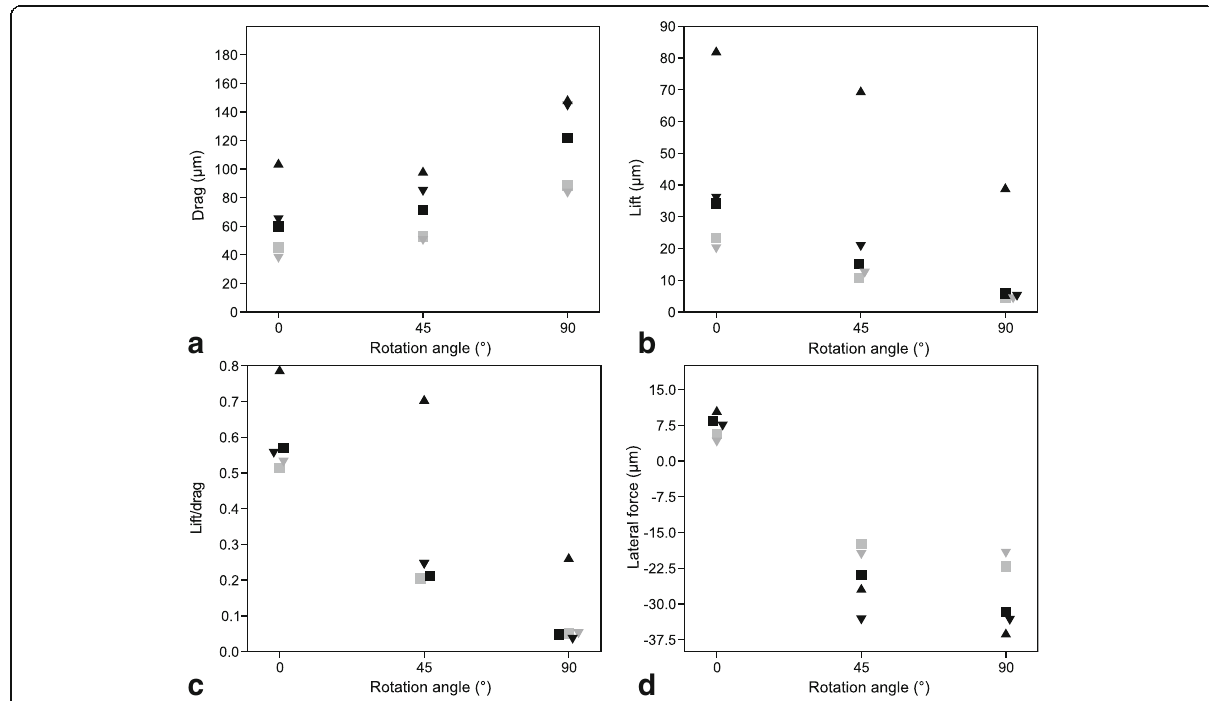
Fig. 4 Drag forces ( a ), lift forces ( b ), lift-on-drag ratio( c ) and lateral forces ( d ) exerted on the shell models at 0.2 m/s flow rate at the different rotation angles in the computational fluid dynamics simulations. Triangle = shell 1; square = shell 2; inversed triangle = shell 3; black = models scaled to same height as shell 1; grey = original size. Overlapping symbols were slightly displaced along the x axis to increase their visualization